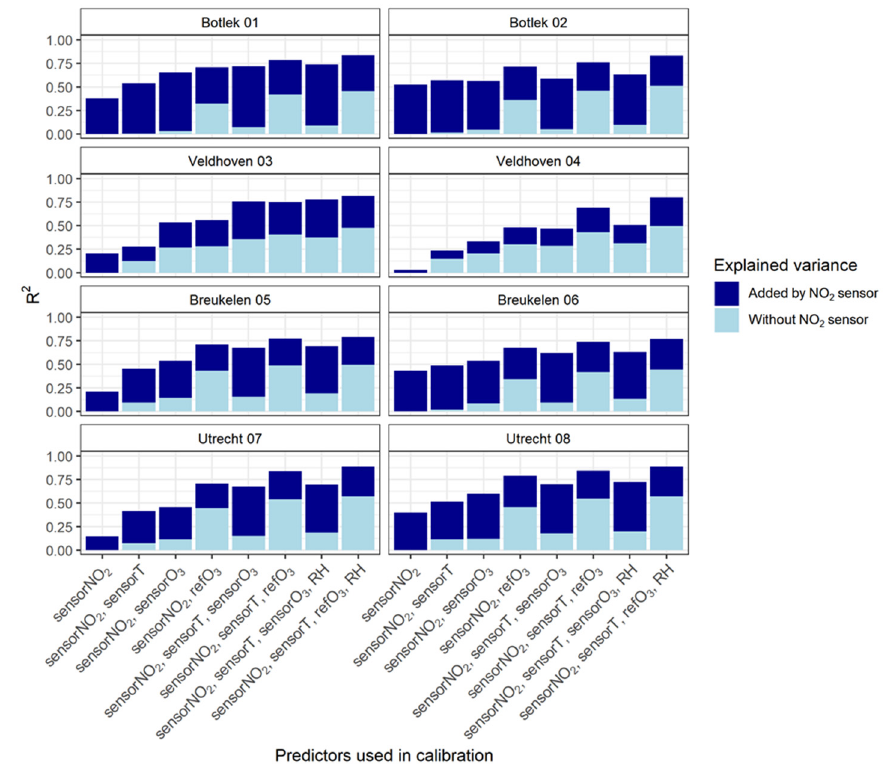
Figure 4. R 2 (coefficient of determination) for the reference NO 2 concentrations versus eight calibration models (horizontal axis). The light blue part in each bar shows the calculated R 2 of the calibration model with the NO 2 sensor data excluded. The dark blue part represents the variance explained by the NO 2 sensor.